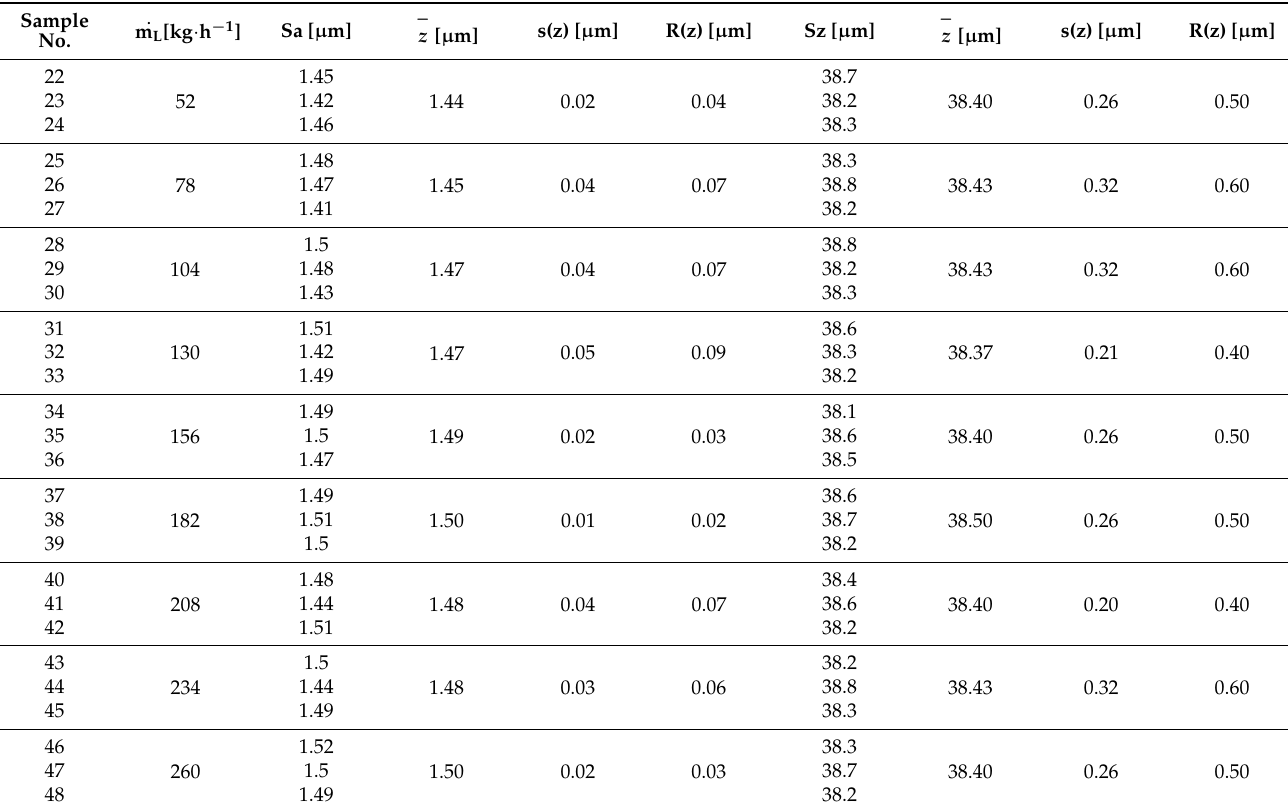
Table 12. Sa and Sz measurement results of polymethyl methacrylate PMMA samples after paint removal (p w = 35 MPa, l 2 = 250 mm, κ = 90 ◦